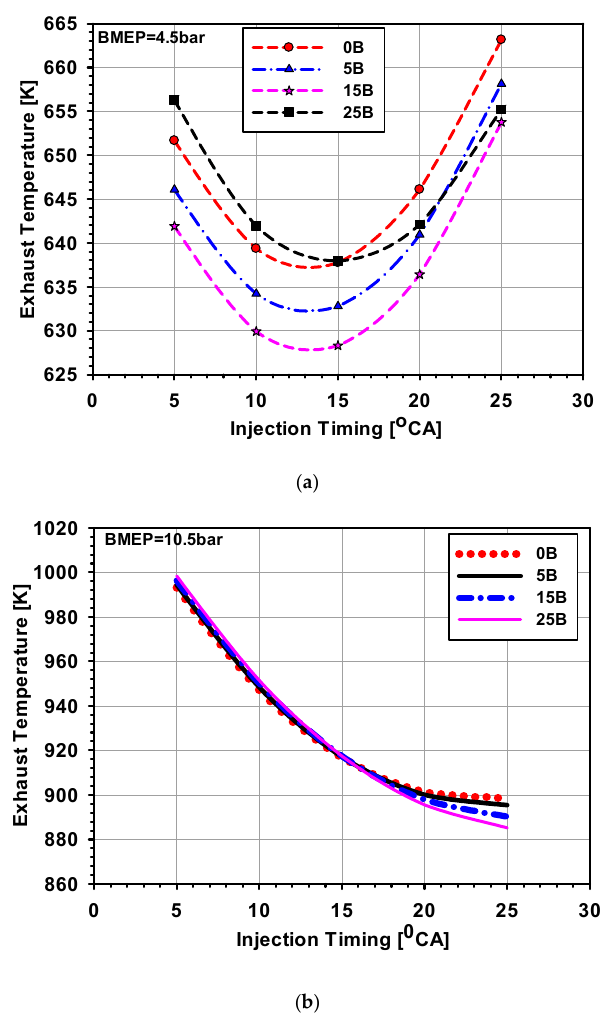
Figure 12. Variation of exhaust temperature for diesel and butanol-diesel blends at: ( a ) BMEP = 4.5 bar; and ( b ) 10.5 bar.